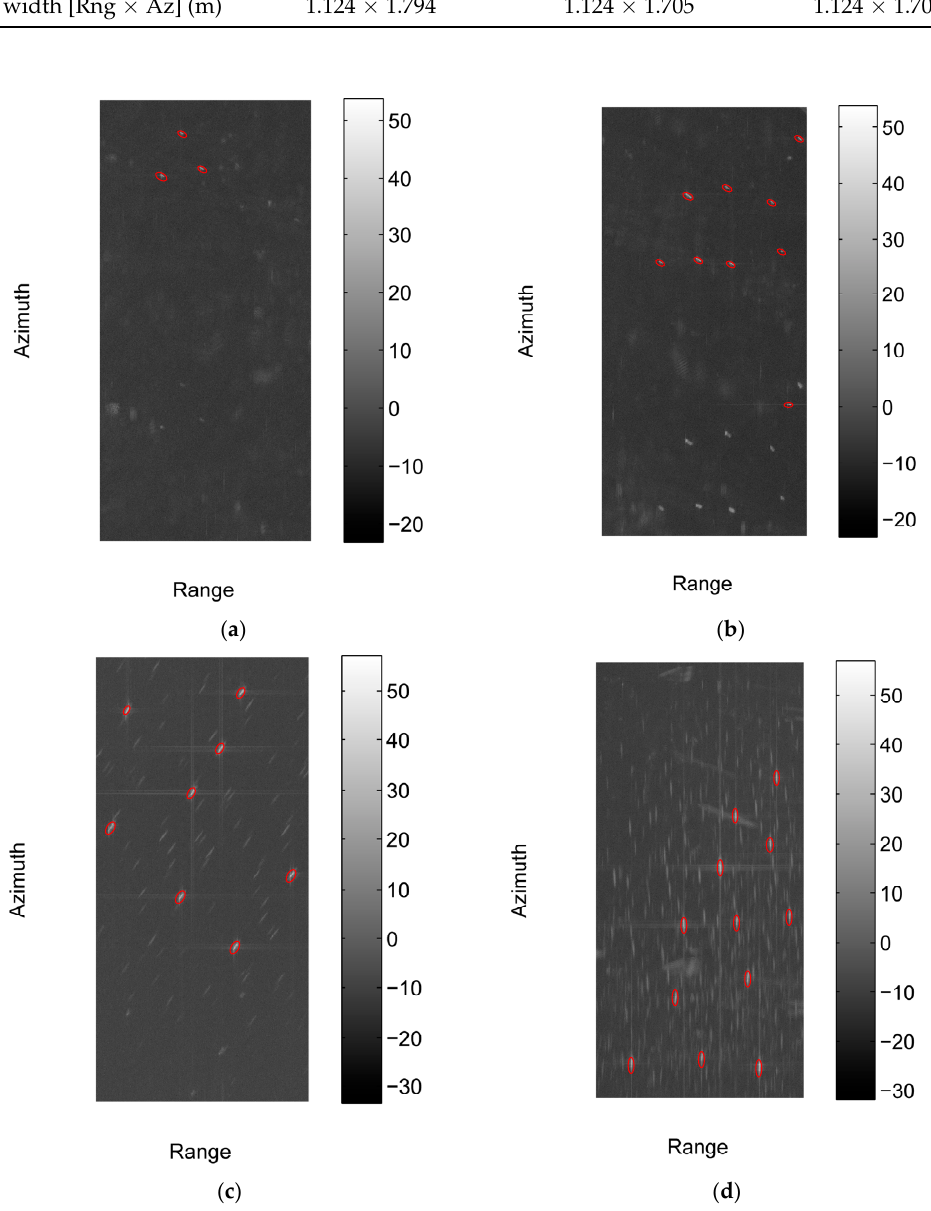
Figure 6. The four sub-images used in the experiment and the manually annotated ships in